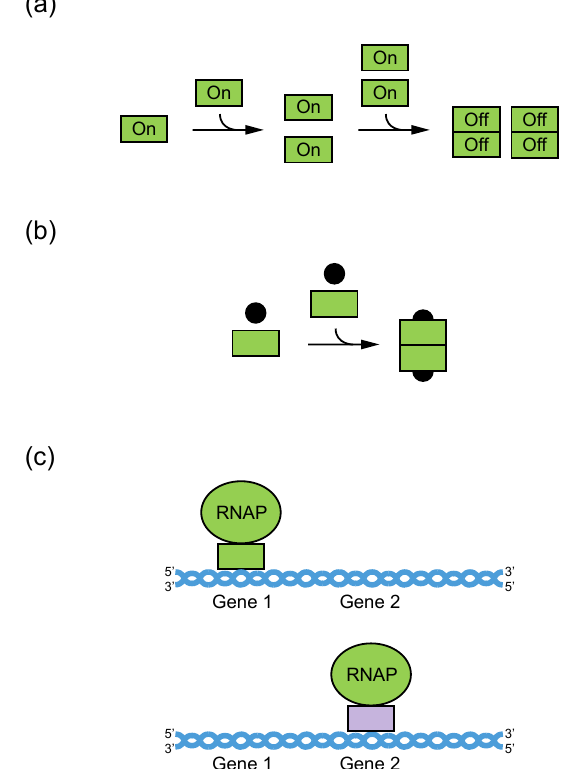
Figure 1. Regulation of biochemical function by multimerization. ( a ) Concentration-based control of biochemical function. In this scheme, monomers are biochemically active and dimers are not. At concentrations below the dissociation constant for dimer formation, most of the population is monomeric and in the active state, while at concentrations above the dissociation constant, most of the population is dimeric and in the inactive state. Green rectangles = nucleic acid or protein monomers. ( b ) Enhanced sensitivity to ligand concentration by cooperative binding. In this scheme, ligand binding is independent when nucleic acid or protein binding sites are monomeric but cooperative when they are linked by multimerization. This leads to all-or-none binding and enhanced sensitivity to ligand concentration. Green rectangles = nucleic acid or protein monomers; black circles = ligands. ( c ) Modulation of biochemical activity by the exchange of dimerization partners. In this scheme, the gene transcribed by RNA polymerase is determined by the DNA-binding specificity of its dimerization partner. Green ovals = RNA polymerase; green and purple rectangles = transcription factors; blue lines = DNA.